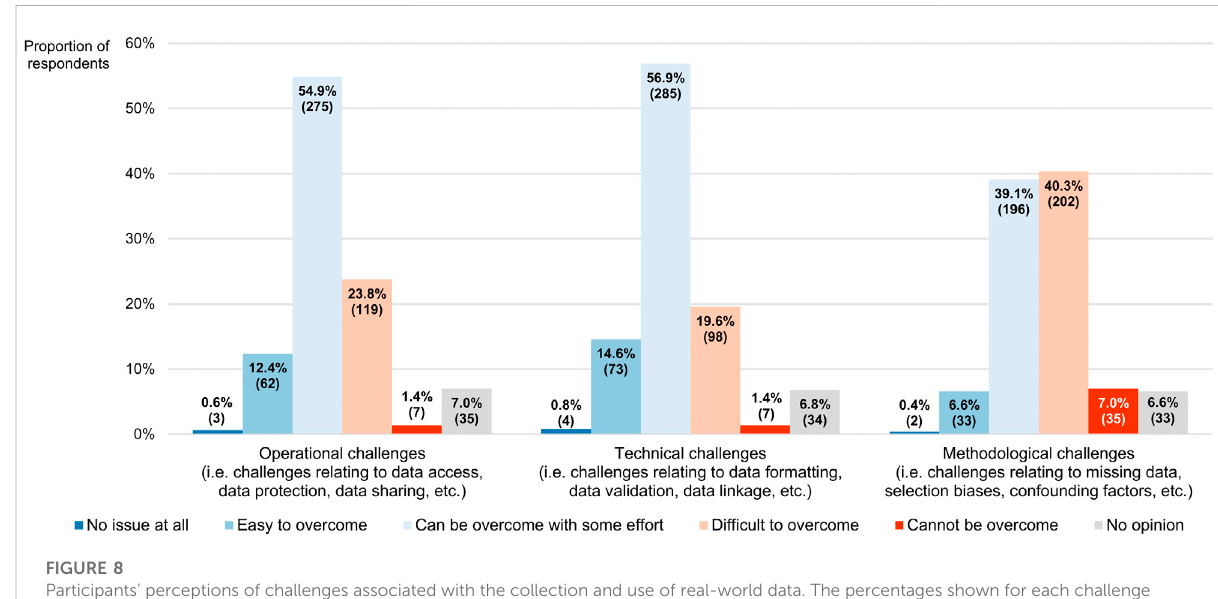
FIGURE 8 Participants ’ perceptions of challenges associated with the collection and use of real-world data. The percentages shown for each challenge may not add up to exactly 100% due to rounding. The numbers in brackets indicate the absolute number of respondents corresponding with each